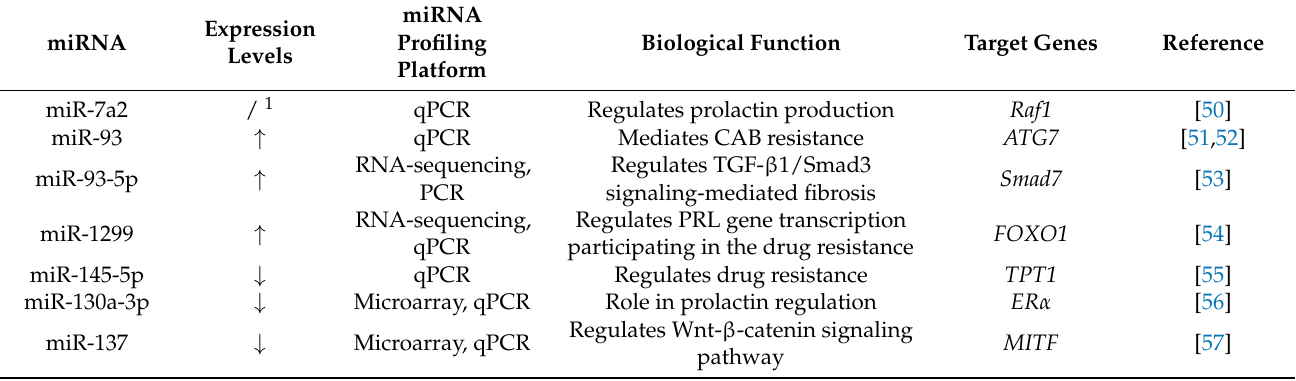
Table 3. Summary of differentially expressed miRNAs with their validated targets in prolactinomas.